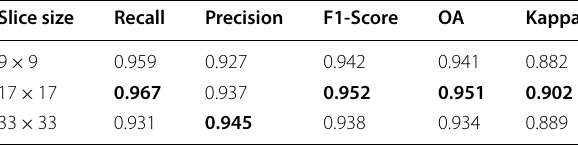
Table 5 Evaluation of the proposed model with the different